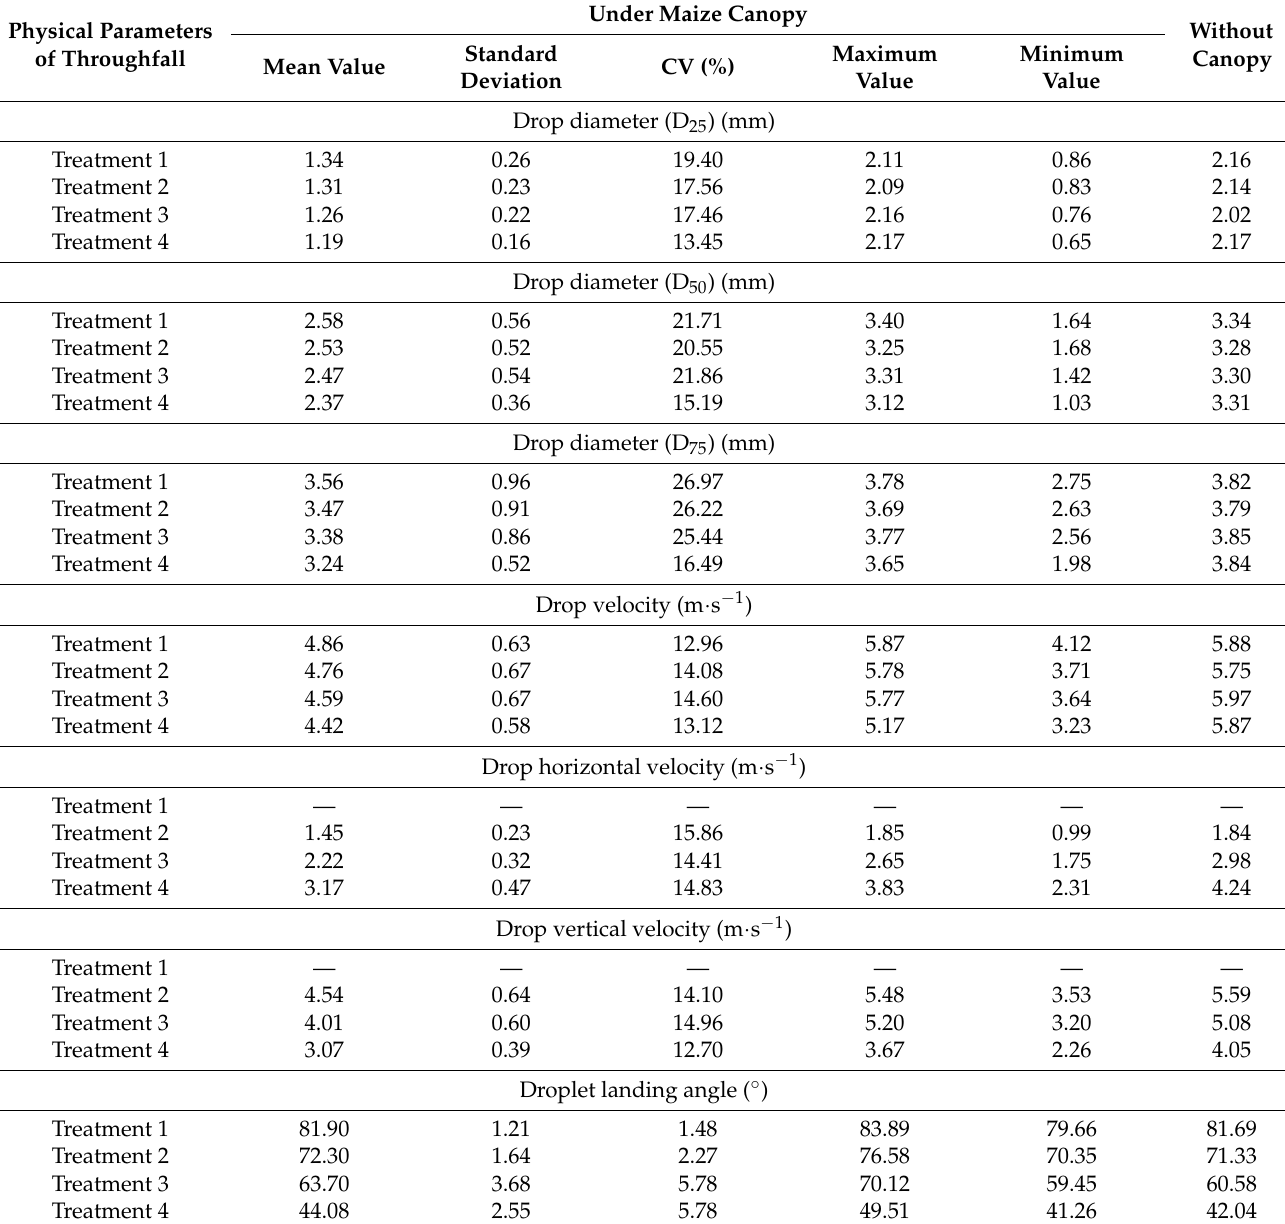
Table 2. Physical parameters of droplet inside and outside maize